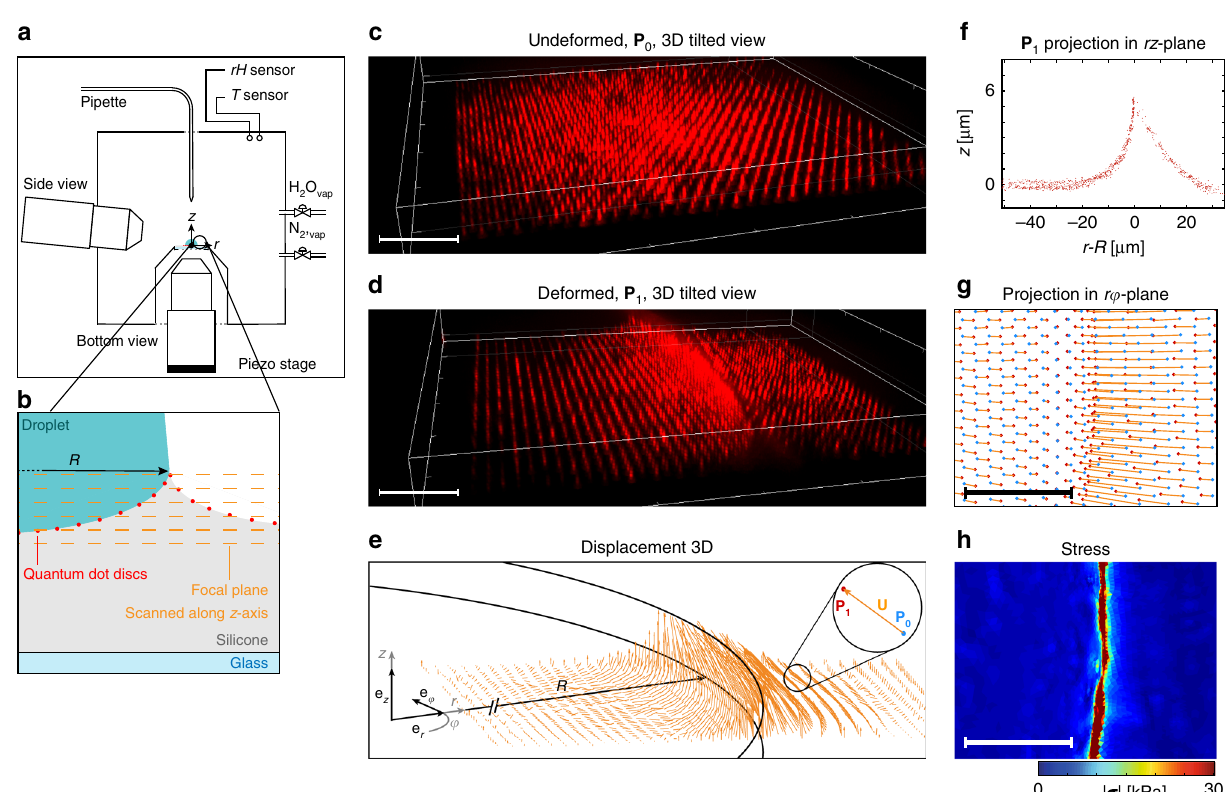
Fig. 2 Detection of transient mesoscale deformation fi elds during droplet drying. a Schematic of the setup used in all experiments. It consists of an environmental chamber, where rH and T are controlled, two objectives (bottom and side views), and a pipette for dispensing droplets. The bottom objective is attached to a piezo stage. b Schematic showing a droplet on a compliant silicone substrate, creating a wetting ridge at its contact line. The surface is patterned with a regular array of quantum dot discs, which are detected by a custom-built bright- fi eld fl uorescence microscope. By scanning in the z - direction, we can determine surface deformations in this direction. Tilted-view fl uorescence micrographs of compliant substrates with a triangular array of red QD discs in the c unloaded (no droplet) and d loaded state (with droplet). Through microscopy, we can detect the placement fi eld of the loaded state, P 1 , and by a relaxation algorithm we can fi nd the unloaded state, P 0 (see Methods, Supplementary Note 1: Reference-free cTFM Measurement and Supplementary Fig. 2). Then the displacement fi eld is de fi ned as U = P 1 − P 0 . In d , we focused only on a small portion of the substrate and contact line in order to reveal the signi fi cant substrate 3D deformations. e 3D displacement fi eld, U , for the deformed substrate shown in ( d ). The displacement vector is de fi ned as, U = U r e r + U φ e φ + U z e z , and each vector is represented by an arrow in ( e ). Also shown in ( e ) is the cylindrical coordinate system; the origin is at the center of the droplet − substrate interface; the black circles represent constant values of r and constant z lines at r = R and z = 0 and z = 6 μ m. f Projection in the rz -plane of all P 1 of the deformed substrate data shown in ( d ). g Magni fi ed projection of U (from e ) in the r φ -plane. In-plane positions (orange lines) of P 0 (blue dots) to P 1 (red dots). h Magni fi ed stress vector fi eld magnitude of the deformed substrate shown in ( d ) computed by fi